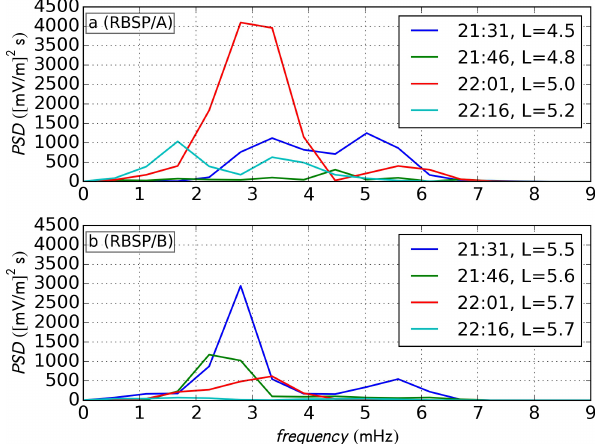
Figure B1. Total magnetic field measured on 8 October 2013 by Dawson City (blue) and Fort Churchill (green) stations from the Canadian magnetometer array CARISMA. The locations of the sta- tions maps approximate to L = 6.1 and 7.4 R E , respectively, under quiet conditions. The longitudinal separation yields shock impulse propagation speed of 780kms − 1